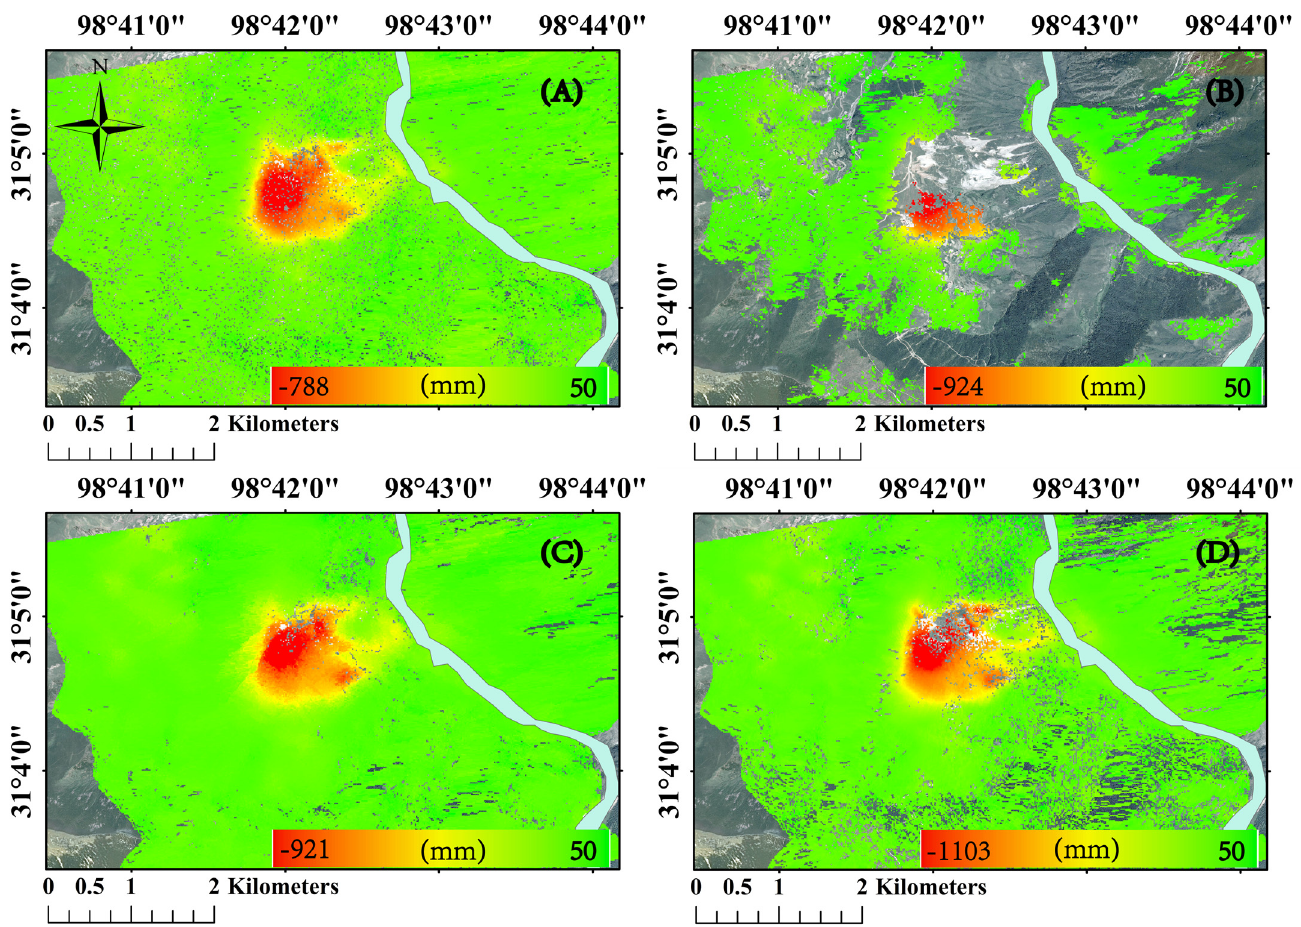
Figure 8. Cumulative deformation by different approaches. ( A ) Traditional ISBAS method with Goldstein filtering; ( B ) DS-SBAS method with Goldstein filtering and the PL method; ( C ) DS-ISBAS method with the SHPs filter and PL method; ( D ) DS-ISBAS method with Goldstein filtering and the PL method.